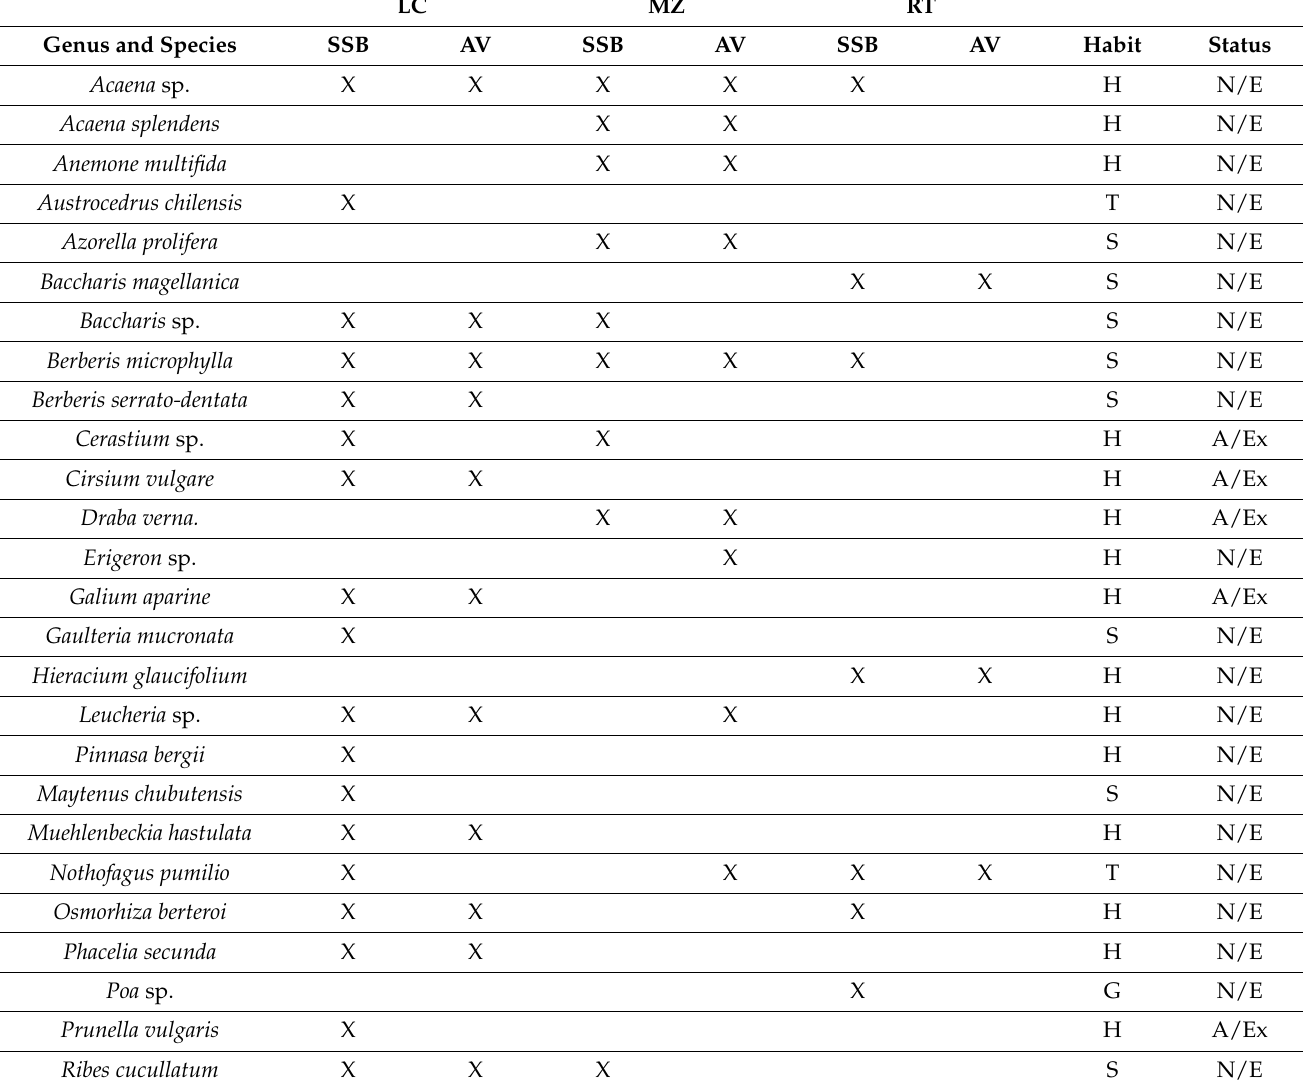
Table 1. Vascular plant species present in both fractions: soil seed bank (SSB) and above-ground vegetation (AV) at each study site La Colisi ó n: LC, Monte Zeballos: MZ and R í o Turbio: RT. Habit and Status according to Zuloaga et al. (2013) H = herbaceous, S = dwarf shrub-shrub and T = trees; N/E = native or endemic and A/Ex = adventive or